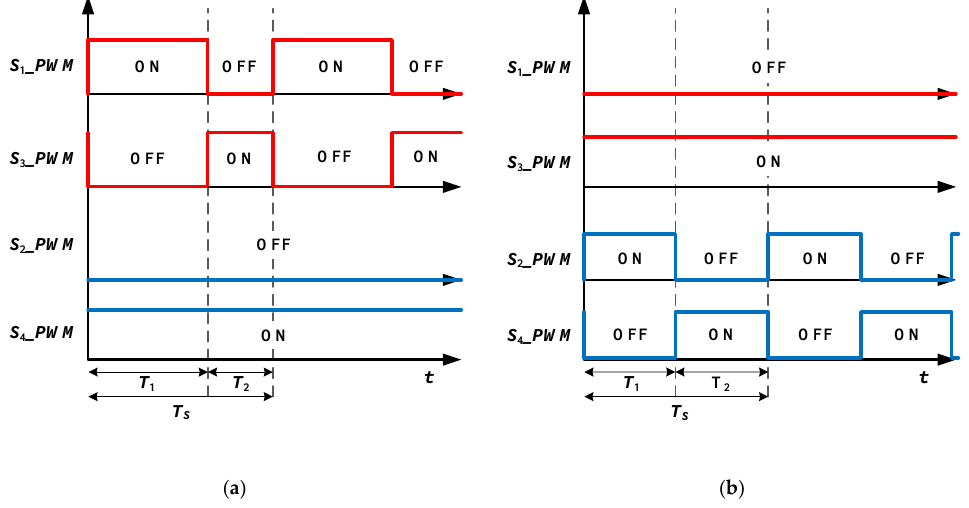
Figure 7. PWM signals of ( a ) The charging scenario A; ( b ) The charging scenario B.